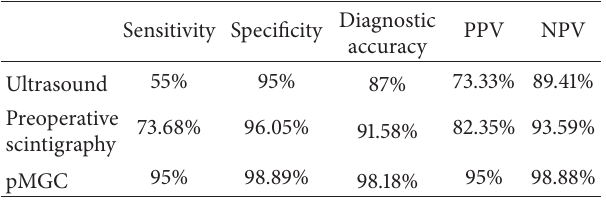
Table 4: Sensitivity, specificity, diagnostic accuracy, PPV, and NPV of the localisation investigations used according to the side of the neck.